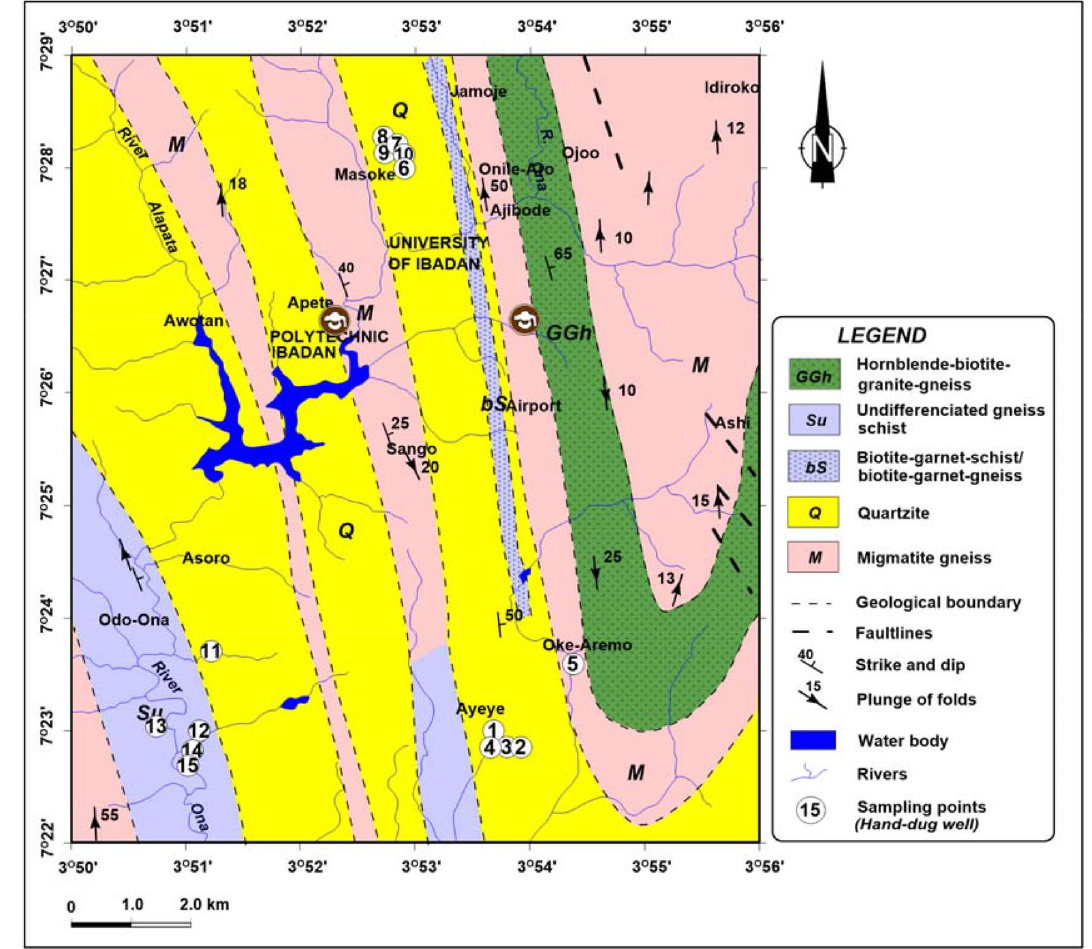
Fig. 1 Geological map showing the rock type that underlies the study area and water sampling locations (after NGSA